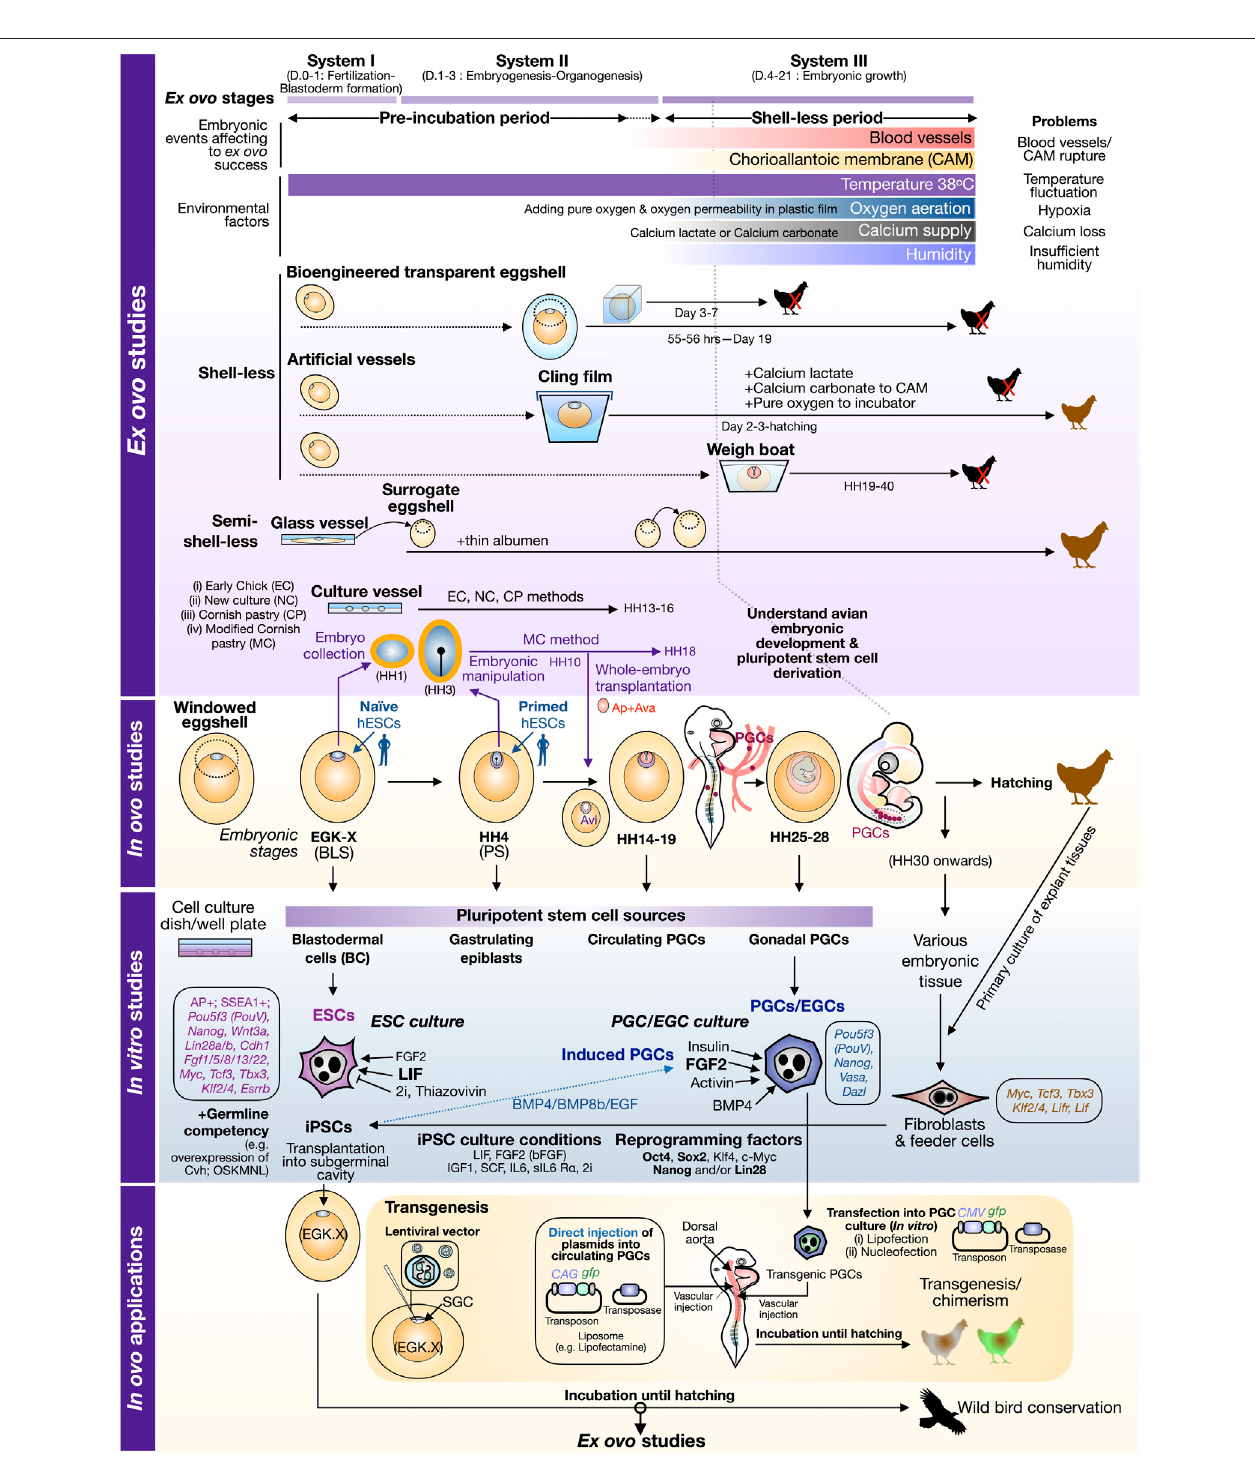
FIGURE 1 | Perspective view of avian embryonic culture with ex ovo – in ovo cultivation and in vitro cell culture. In the schematic illustration of ex ovo studies, avian embryosatearlystagescanbecollectedintoculturevessels(e.g.,Petridish)andculturedunderchemicallyde fi nedsolutions(aslistedin Table1 ).In “ shell-less ” culture, experimentsaimedtonourishembryoswithoutnaturaleggshellsuntilhatching.Speci fi ctypesofshell-lessculturesaredescribedin Table1 .In “ semi-shell-less ” culture, early embryos are temporarily cultured in the culture vessels and later transferred to surrogate eggshells with the addition of thin albumen. A bigger eggshell is also required at the transition from embryonic system II to III. Environmental factors and potential problems affecting the success of ex ovo culture are noted in relation to embryonicsystemsI – III. Inovo culturedepictstheearlystages(EGKXtoHH28,day0 – 5)ofavianembryosusingachickasamodel.Theearlyembryonicstageofachick